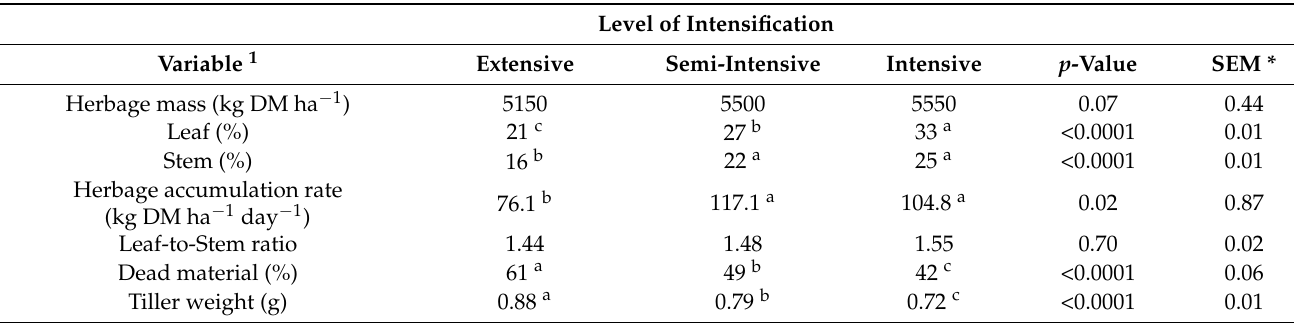
Table 3. Herbage mass; proportions of leaf, stem, and dead material; leaf-to-stem ratio; accumulation rate; tiller weight of marandu palisadegrass ( Urochloa brizantha ‘Marandu’) pastures under different levels of pasture